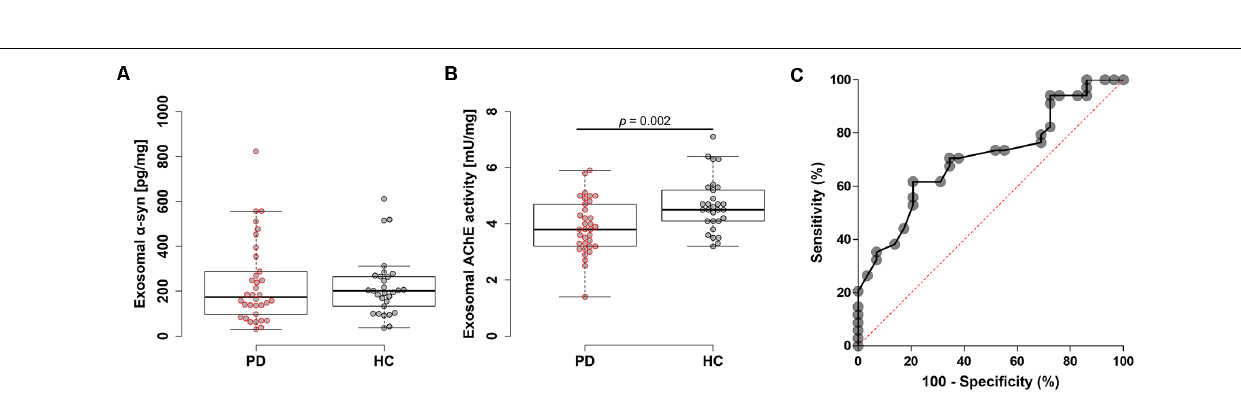
FIGURE 1 | Characteristics of the isolated exosomes by ultracentrifugation. (A) Representative transmission electron micrograph of isolated plasma exosomes (Scale bar = 100 nm). (B) A representative plot depicting the size and concentration of exosomes. (C) Western blot of the exosomes from Parkinson’s disease (PD) and healthy controls (HC) individuals with specific antibodies against Alix and GM130 as positive and negative controls, respectively.